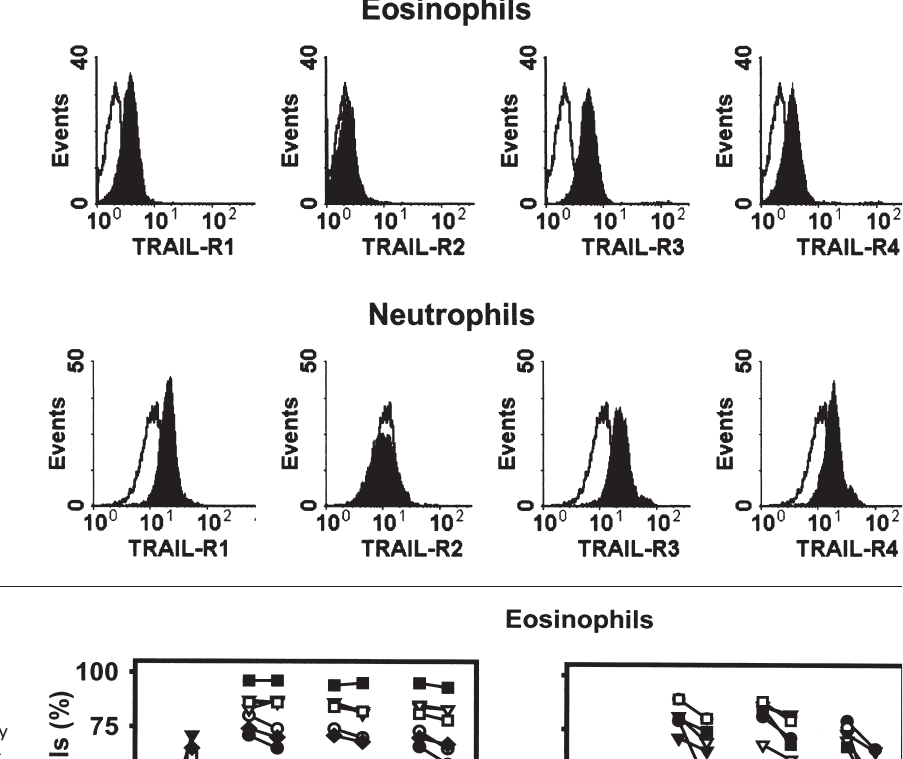
Cell death regulation by TRAIL in vitro. Granu- locytes were cultured alone or in the presence of TRAIL with enhancer for 40 hours. When in- dicated, cytokines were added at a concentra- tion of 50 ng/ml. Cell viability was measured by ethidium bromide exclusion and flow cytomet- ric analysis. Upper left panel: TRAIL can induce survival in a proportion (6 out of 11) of eosinophil popula- tions (untreated: 27 ± 4%; TRAIL: 55 ± 4%; GM- CSF: 85 ± 3%). In these eosinophil populations, TRAIL did not inhibit survival induced by GM-CSF, IL-5, or IFN- γ . Six independent experi- ments are presented. Upper right panel: In other eosinophil popula- tions (5 out of 11), TRAIL treatment had no direct effect on survival (untreated 27 ± 4%; TRAIL: 25 ± 3%; GM-CSF: 78 ± 4%). TRAIL partially inhibited survival signals provided by GM-CSF, IL-5, and IFN- γ in these eosinophil preparations. Lower panel: TRAIL did not induce neutrophil survival or death (untreated: 30 ± 3%; TRAIL: 33 ± 4%; GM-CSF; 54 ± 4%). However, TRAIL partially inhibited the survival signals provided by GM-CSF, G-CSF, and IFN- γ . Six independent experiments are presented. Results using a concentration of TRAIL of 100 ng/ml are presented, but similar results were obtained using TRAIL in a concentration range of 10 to 200 ng/ml (not